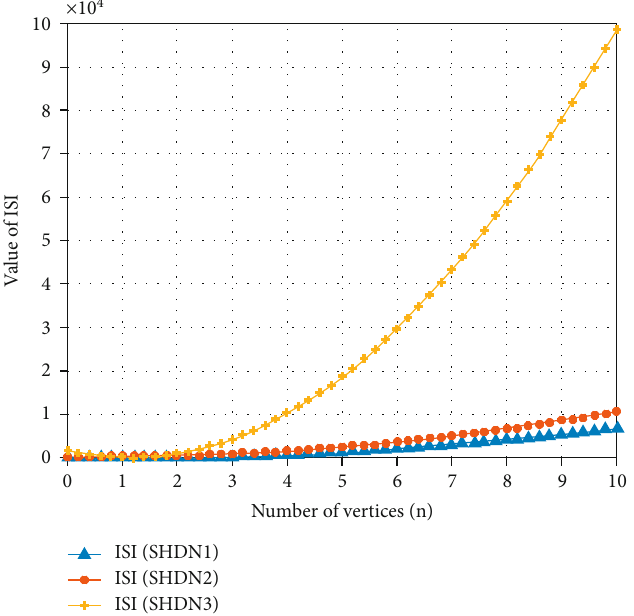
n Þ , Γ n Þ , and Γ n Þ using 2D graphs of ISI 1 ð 2 ð 3 ð